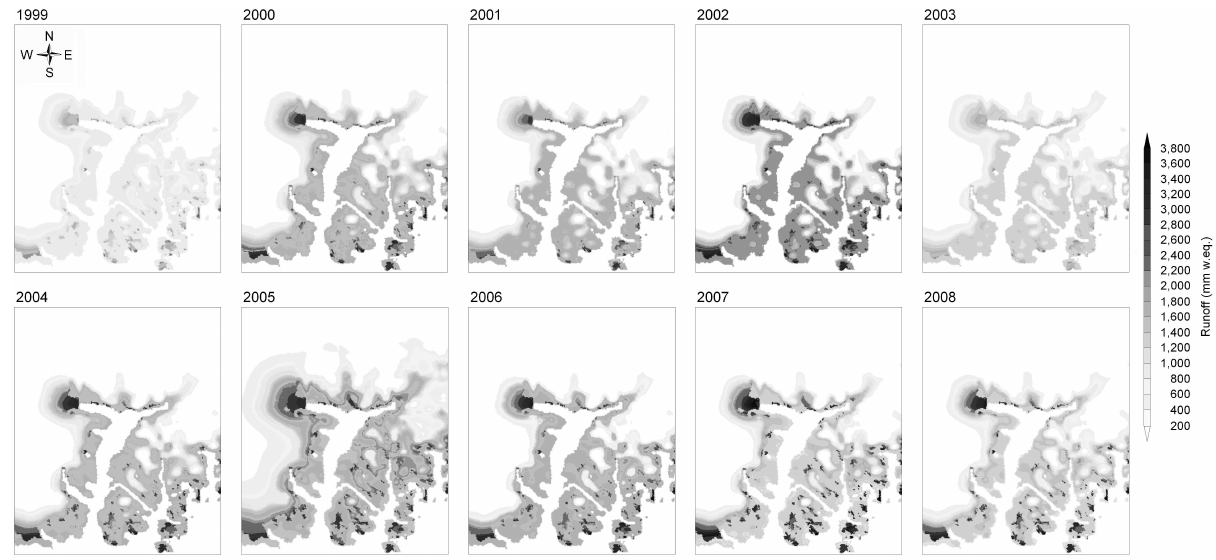
Fig. 5. Spatial simulated annual cumulative runoff within the area of interest to the Sermilik Fjord for